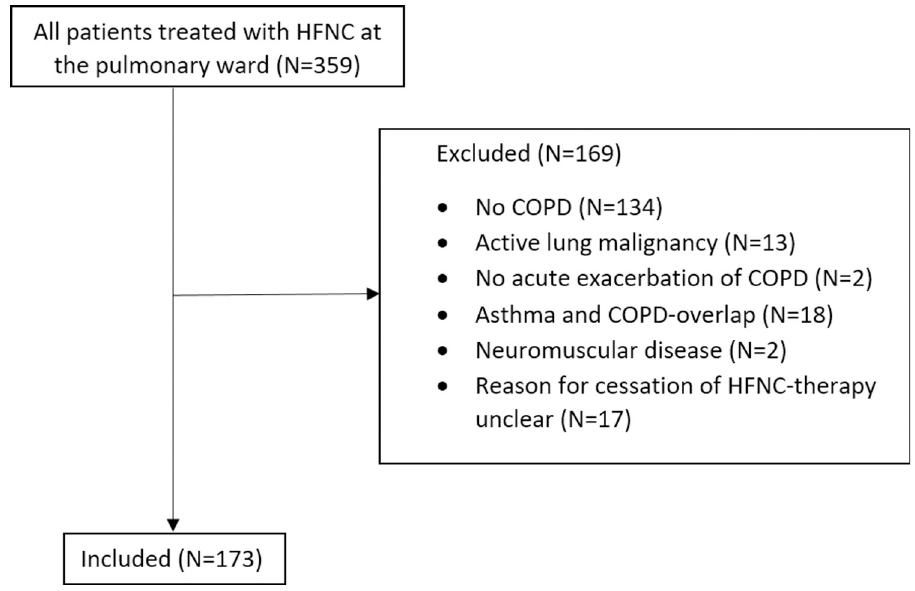
Fig 1. Flowchart of all included